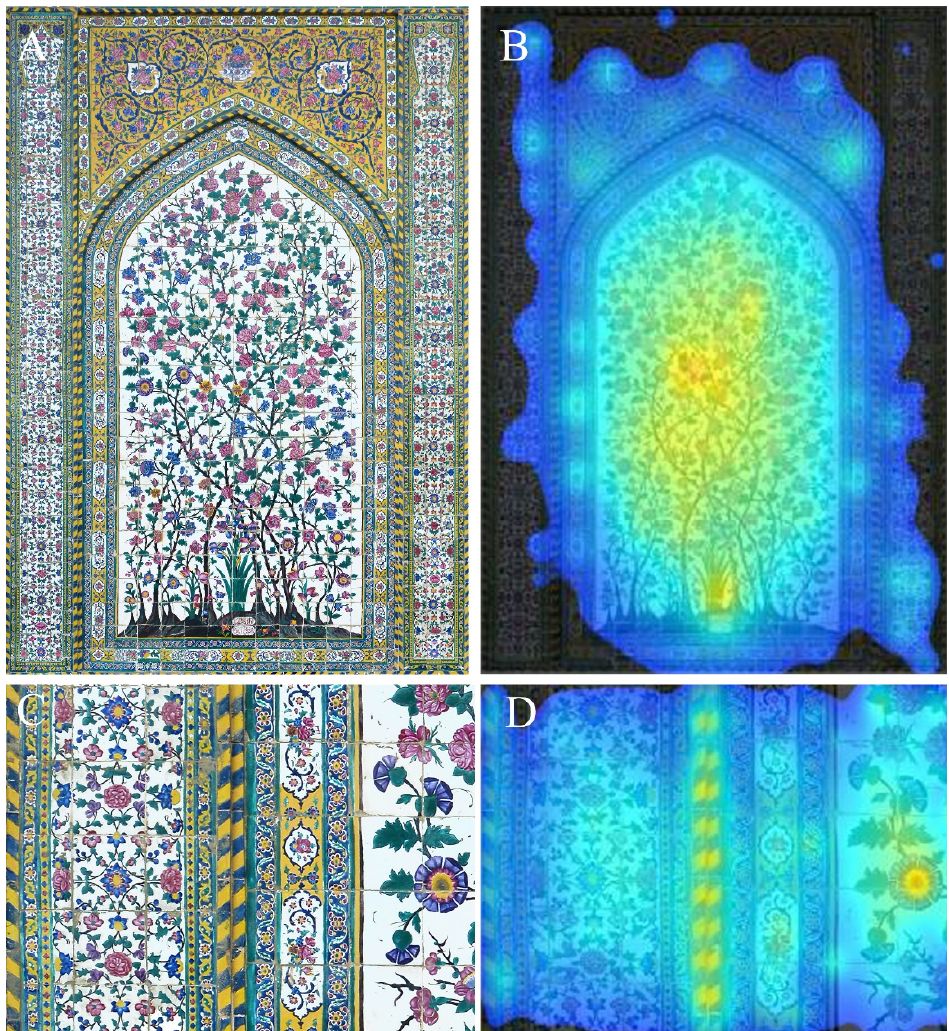
Figure 10. A complete tiled ceramic mural from the 18th century Vakil mosque in Shiraz, Iran ( A ), with its eye-tracking simulation heatmap ( B ). On closer approach, more details become visible ( C ), so that the new eye-tracking simulation heatmap remains uniformly coherent ( D ).